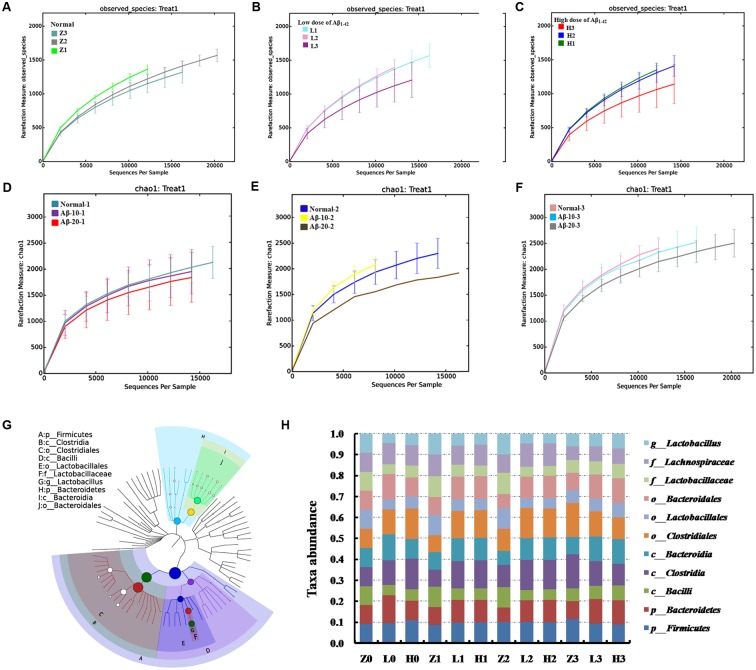
Effects of Aβ1-42 on gut microbiota in rats. (A–F) The rarefaction curve of different concentrations and durations in Aβ1-42-induced groups, H (20 μg of Aβ1-42), L (20 μg of Aβ1-42), Z (normal rats with vehicle); H1, H2, and H3 (or L1, L2, L3) is the treatment time after injection of Aβ1-42 at 2nd, 3rd, and 4th weeks; (G) is the dominant species classification tree; (H) is the relative abundance of the dominant microorganism. Values represent the means of six independent experiments.